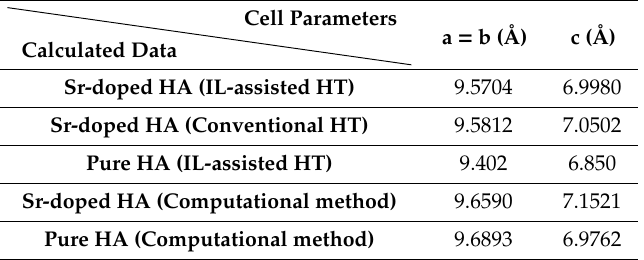
Table 1. Experimental and computational calculated unit cell parameters of the as-prepared products.